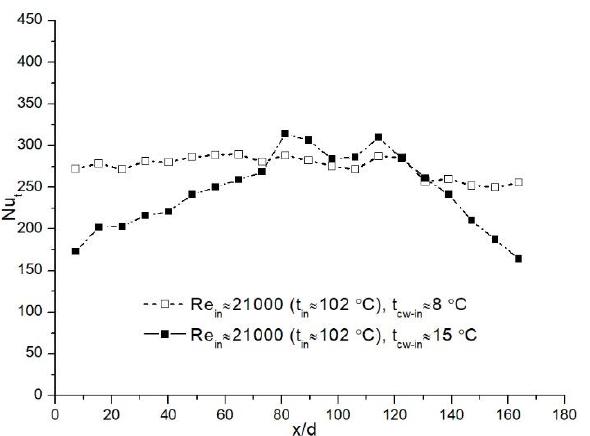
Figure 13. Distribution of the Nu t in the heat exchanger at Re in ≈ 21,000, the same flue gas inlet temperature, cooling water flow rate, and cooling water inlet temperatures.